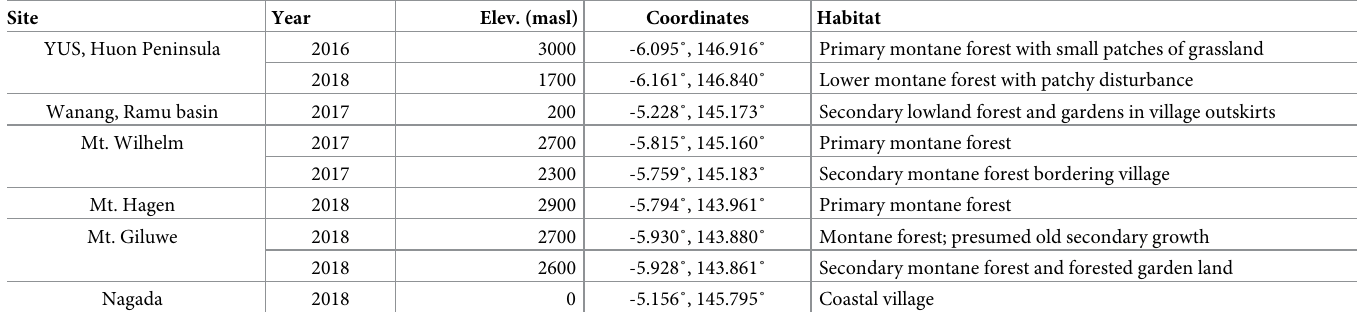
Table 1. Study area details, including year visited, elevation, geographic coordinates, and brief habitat